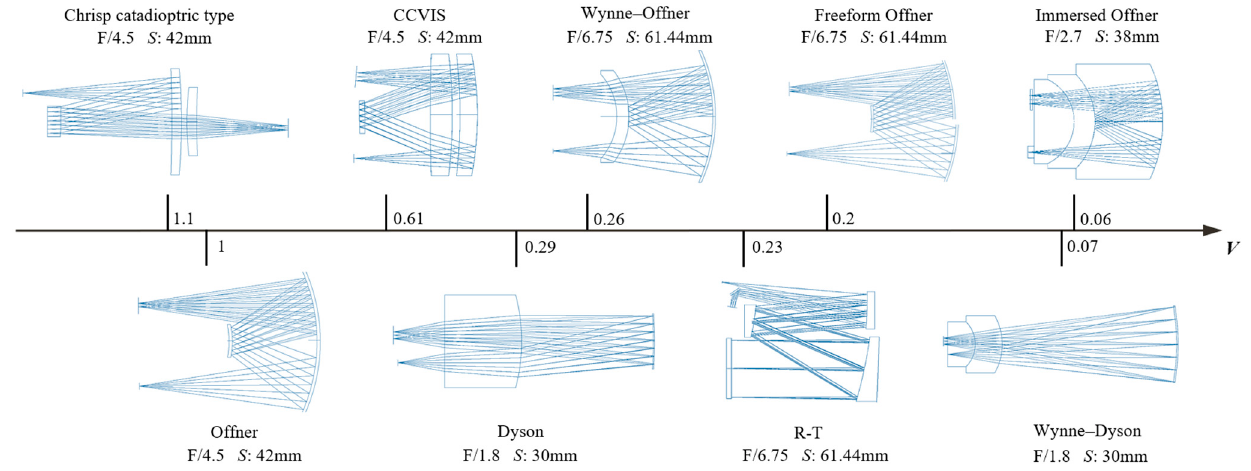
Figure 5. Optical path diagrams of different configurations and their volume.